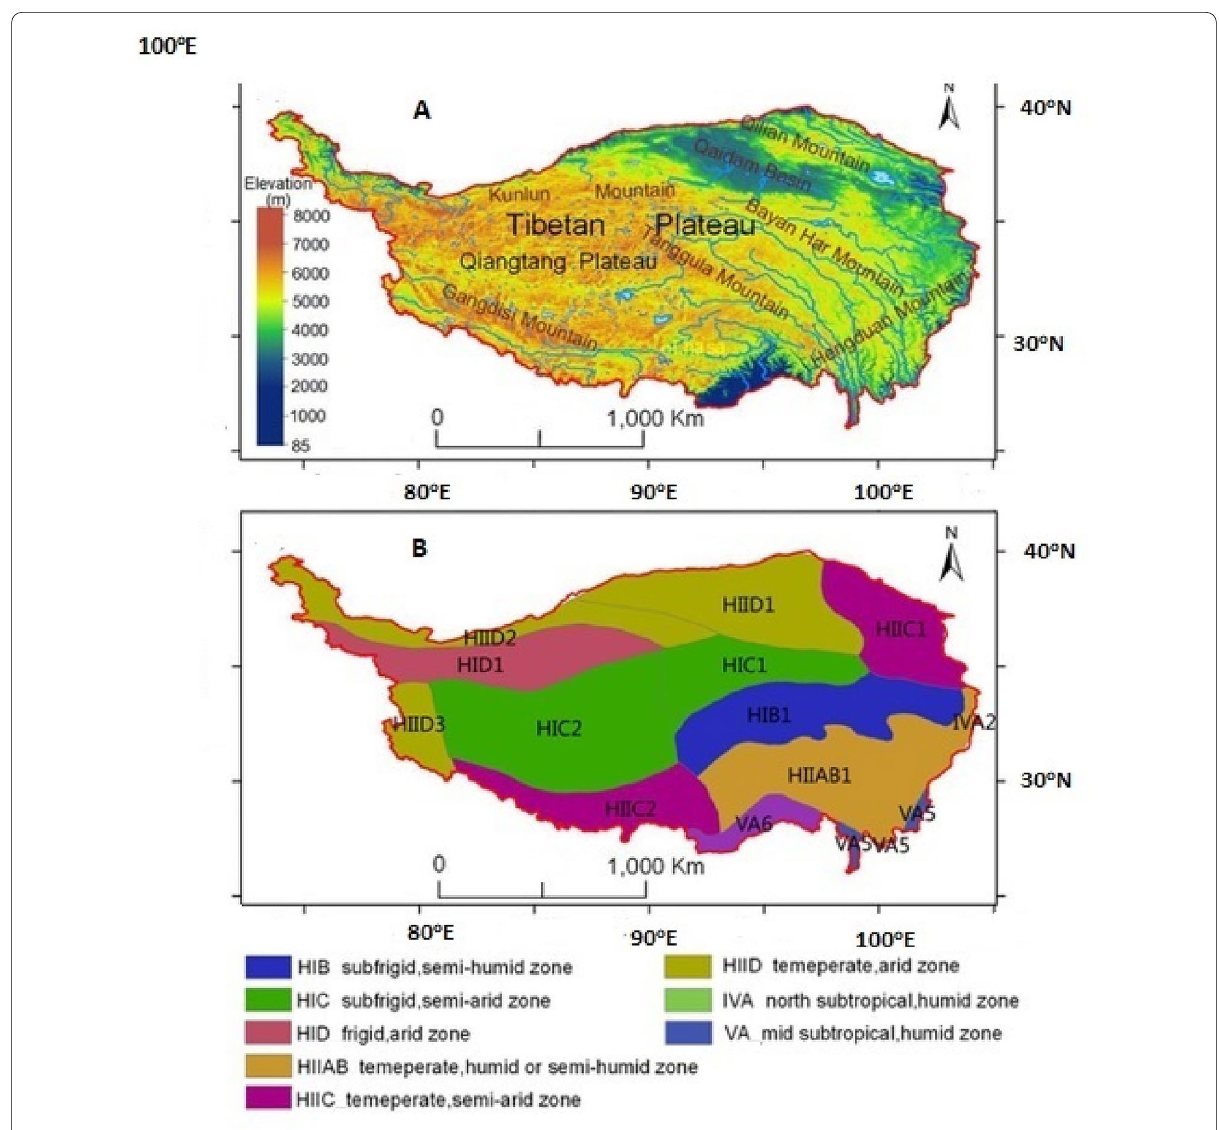
Fig. 5 A Qinghai-Tibet Plateau elevation map. B Ecoregion map of Qinghai-Tibet Plateau Data source Wu et al. (2003a,